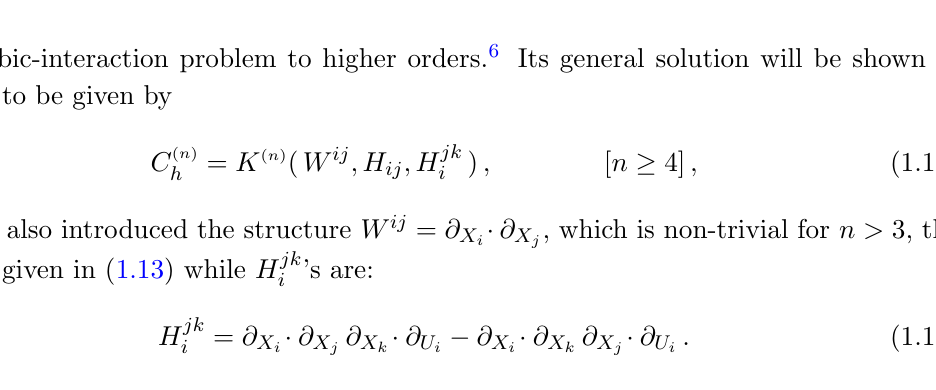
Figure 2 . Schematic diagram of the coupling